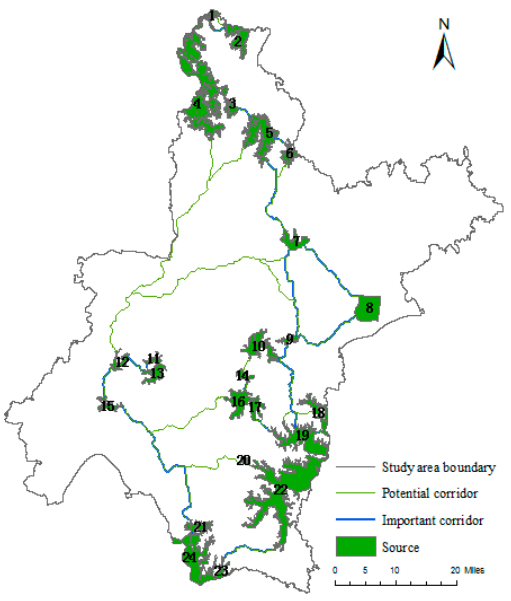
Figure 8. Potential corridor map of the study area.